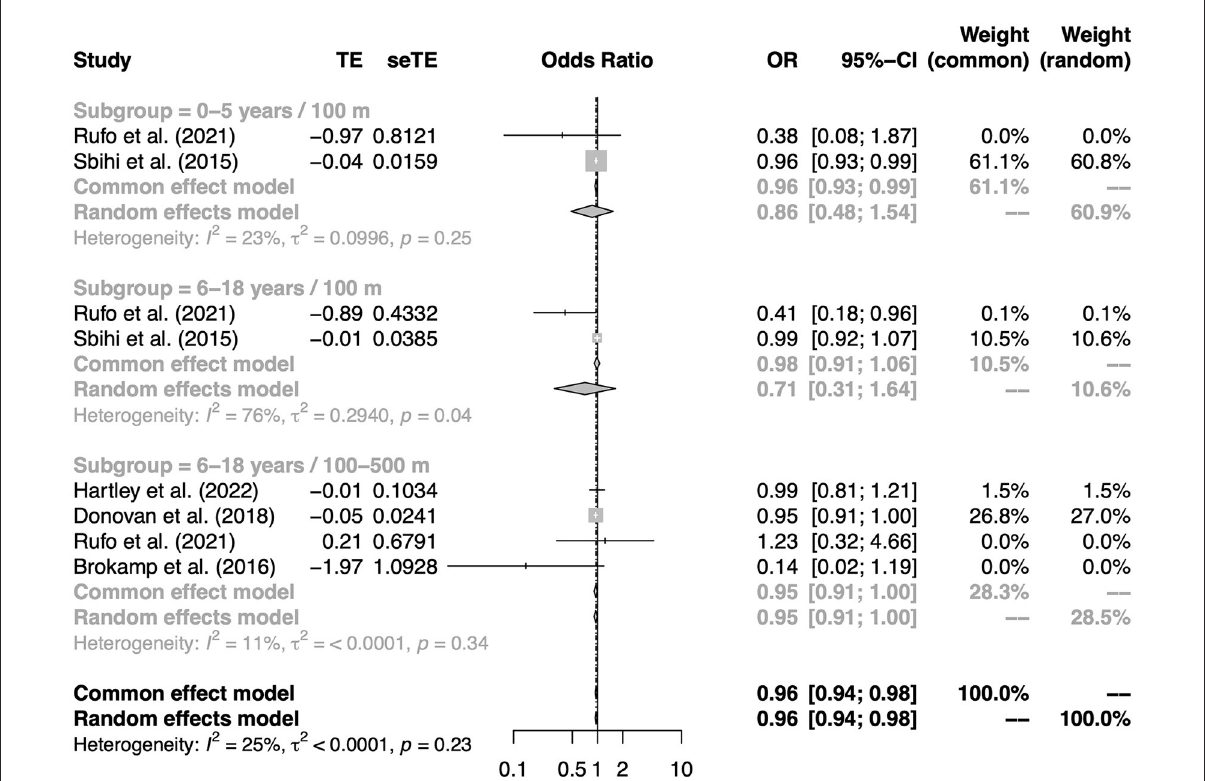
FIGURE3 The association between residential greenness at birth and asthma in childhood. Subgroups were defined according to the age of the outcome measure and the buffers of the exposure